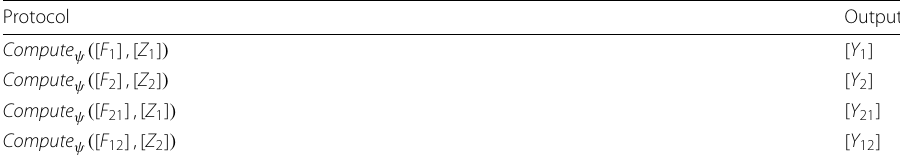
Table 3 Computation protocol run by C per